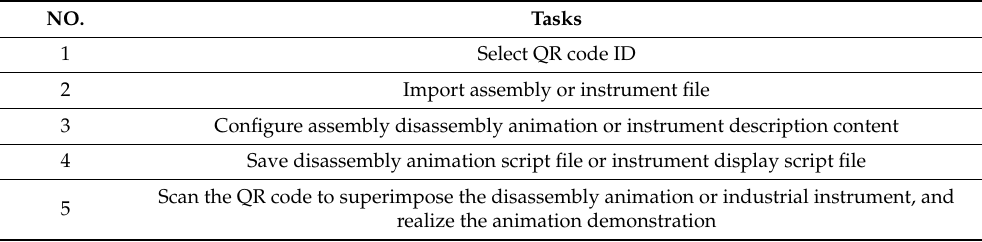
Table 3. AR registration task based on QR code.